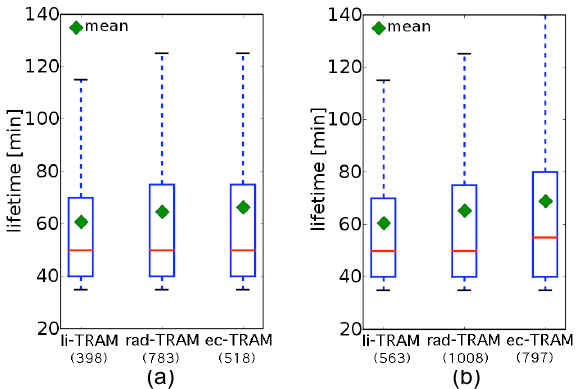
Fig. 7. Comparison between lifetime frequency distributions for cell tracks recorded by li-TRAM, rad-TRAM, and ec-TRAM. The min- imum duration is set to 35min (see text). The median, 25th, and 75th quantile are plotted as red-blue box-and-whisker plots com- plemented by the mean values marked as green diamonds. Distri- butions are shown for (a) completely assessed cell tracks and (b) all recorded cell tracks comprising complete and incomplete tracks. Total number of tracks used for the calculation is written below the respective labelling.